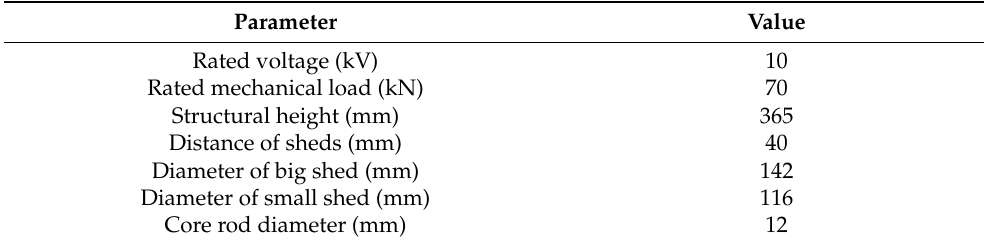
Table 1. Composite insulator parameters.